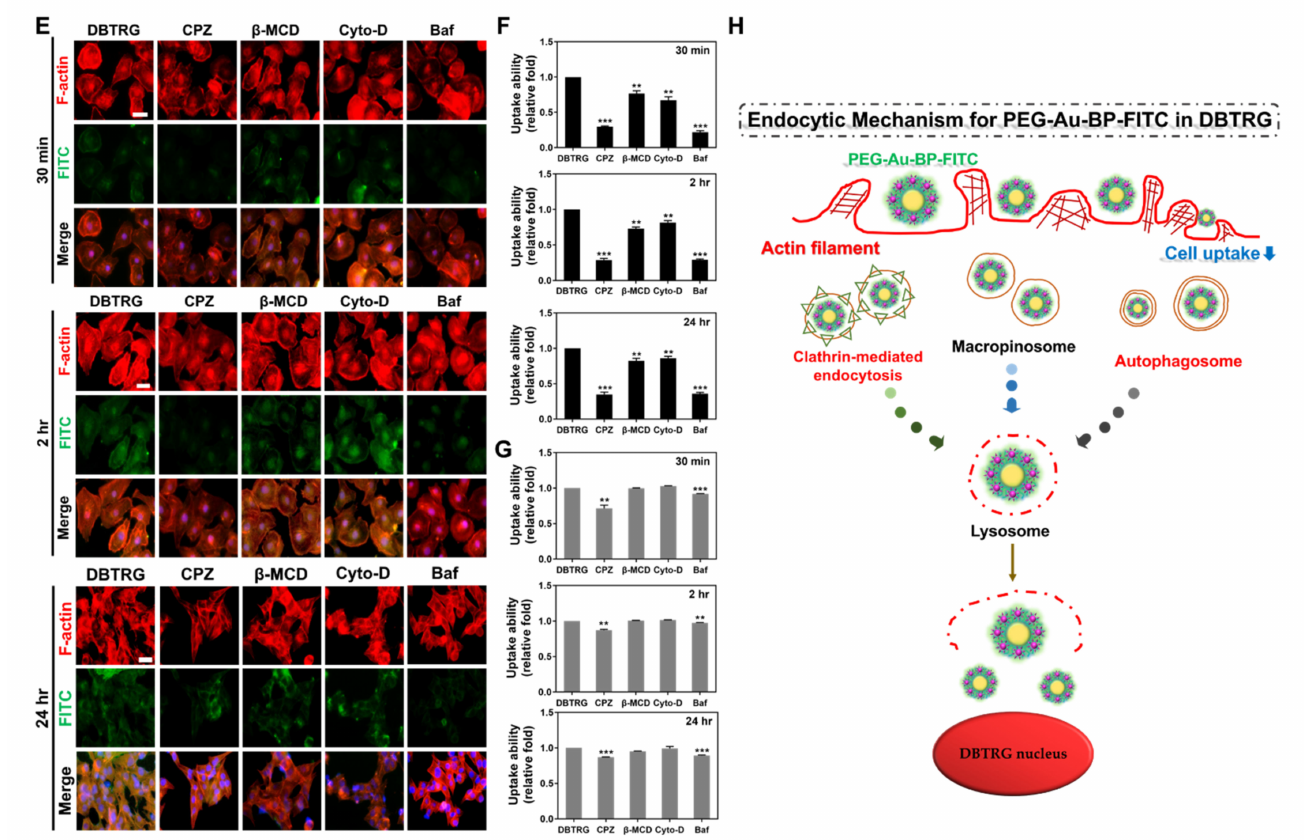
Figure 6. Investigation of endocytic routes in BAEC and DBTRG cell lines. The endocytosis mech- anisms were caveolae, macropinocytosis, receptor-mediated endocytosis, and phagocytosis. Af- terwards, four different endocytic inhibitors, CPZ, β -MCD, Cyto-D, and Baf, were treated with both cell lines at different time points (30 min, 2 h, and 24 h) to investigate the cell entry process. ( A ) The immunofluorescence images of BAEC uptake of PEG-Au-BP at each time point. ( B ) The quantitative results of fluorescence intensity based on the IF method indicate that PEG-Au-BP colo- calized with F-actin was significantly reduced after being treated with CPZ (30 min (~0.19-fold), 2 h (~0.55-fold), 24 h (~0.36-fold)) and Baf (30 min (~0.68-fold), 2 h (~0.32-fold), 24 h (~0.36-fold)). ( C ) Furthermore, the fluorescein-positive cells semi-quantified by the FACS method significantly decreased when influenced by CPZ (30 min (~0.72-fold), 2 h (~0.91-fold), 24 h (~0.80-fold)) and Baf inhibitors (30 min (~0.94-fold), 2 h (~0.96-fold), 24 h (~0.81-fold)) at each time point. ( D ) Schematic illustration of endocytic routes for normal BAEC. ( E ) The immunofluorescence images of DBTRG brain cancer cells uptake of PEG-Au-BP at each time point. ( F ) According to the results quantified by the IF method, the uptake amount in DBTRG significantly decreased in CPZ (30 min (~0.29-fold), 2 h (~0.28-fold), 24 h (~0.34-fold)) and Baf (30 min (~0.21-fold), 2 h (~0.29-fold), 24 h (~0.34-fold)) treatments. ( G ) The uptake amount quantified by the FACS method demonstrated a similar trend with the IF method, while the CPZ (30 min (~0.71-fold), 2 h (~0.87-fold), 24 h (~0.88-fold)) and Baf (30 min (~0.91-fold), 2 h (~0.97-fold), 24 h (~0.89-fold)) group was remarkably lower than the control group. ( H ) Schematic illustration of endocytic routes for DBTRG brain cancer cells. Results were represented as the mean ± SD ( n = 3). Red color: F-actin. Blue color: cell nuclei. Green color: FITC-labeled PEG-Au-BP. The scale bar equals 20 µ m.* p < 0.05, ** p < 0.01, *** p < 0.001: compared to the 30 min